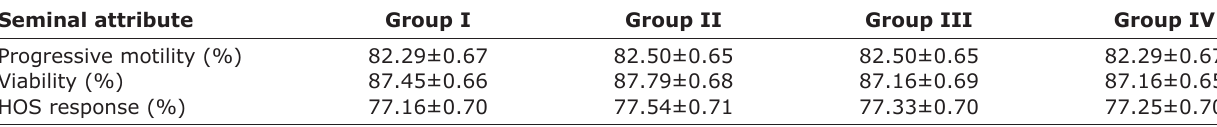
Table-1: Mean±SE of effect of incubation on progressive motility, viability and HOS response at fresh stage. Seminal attribute